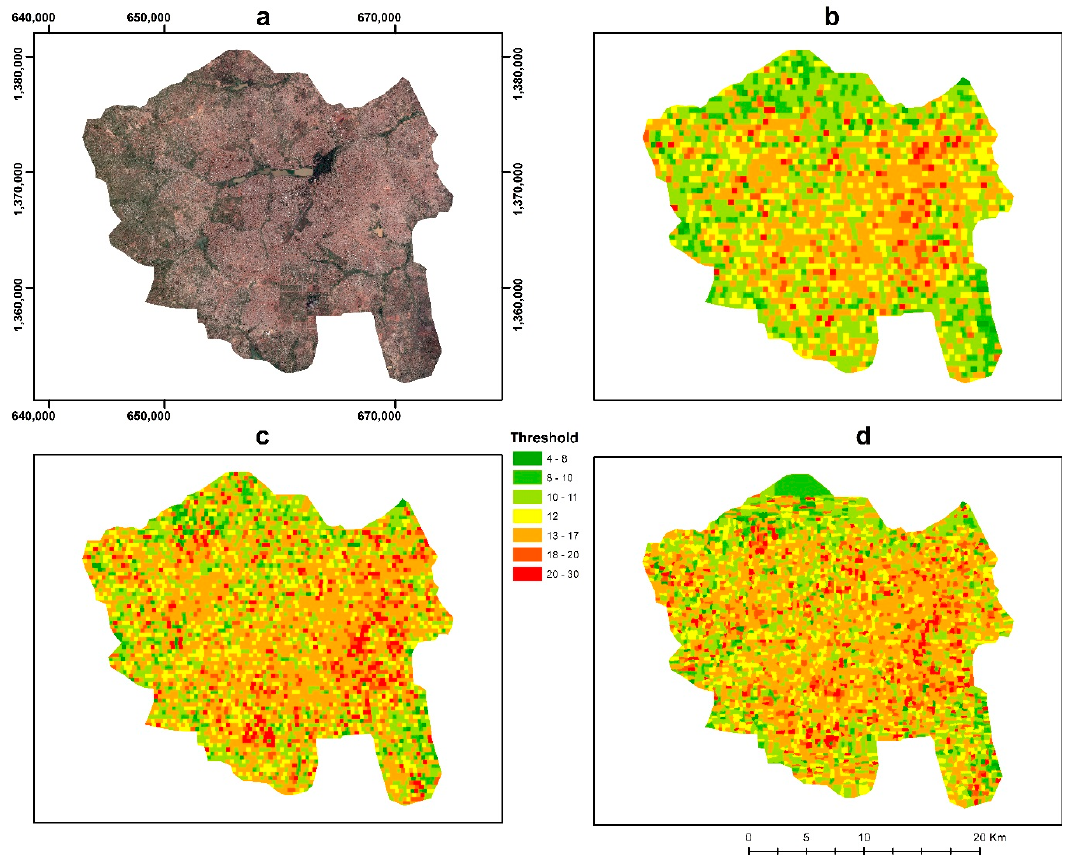
Figure 5. Spatial variation of the threshold parameter (TP) across Ouagadougou. ( a ) WorldView- 3 RGB composite, partitioning by ( b ) P1 ( c ) P2 and ( d ) P3 approaches, respectively. The TP controls the average size of the created segments.